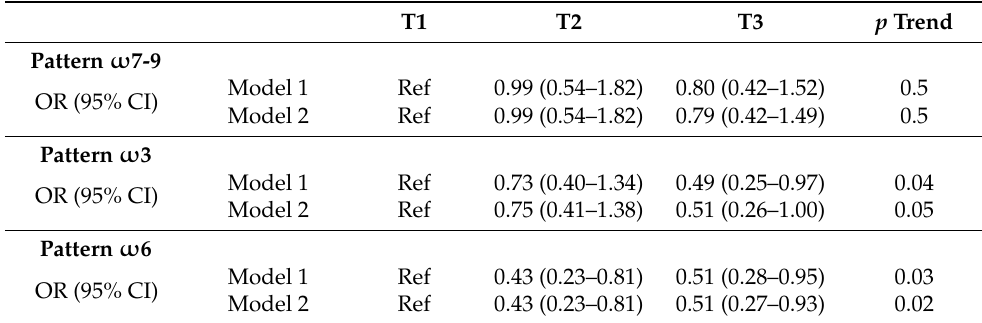
Table 5. Multivariate analysis of the association between FA patterns and 6-month high disease activity (DAS28 ≥ 5.1) ( n =